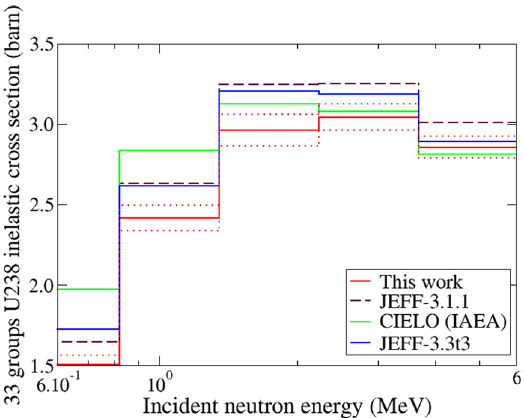
Fig. 13. 33-group assimilation results (case where fi ssion spectra are not fi tted and graphite evaluation used is from JEFF-3.1.1) for 238 U inelastic compared with “ a priori ” JEFF-3.1.1, CIELO and JEFF-3.3t3 evaluation. Posterior uncertainties for assimilation results are in dotted